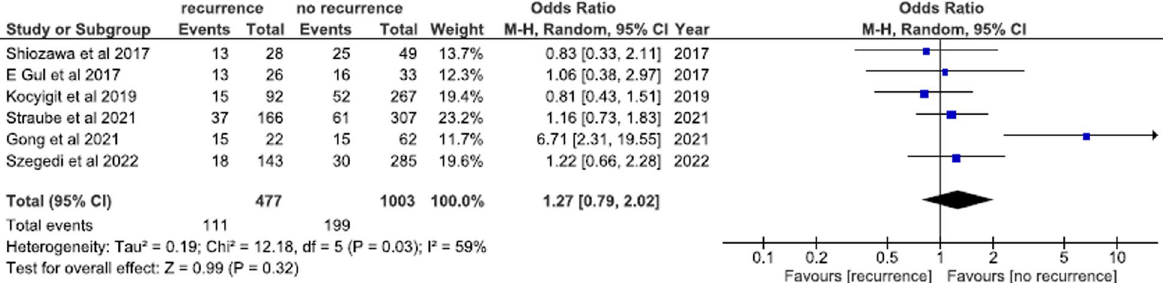
Fig. 4 Chicken wing versus non-chicken wing LAA morphology between arrhythmia recurrence and arrhythmia free groups